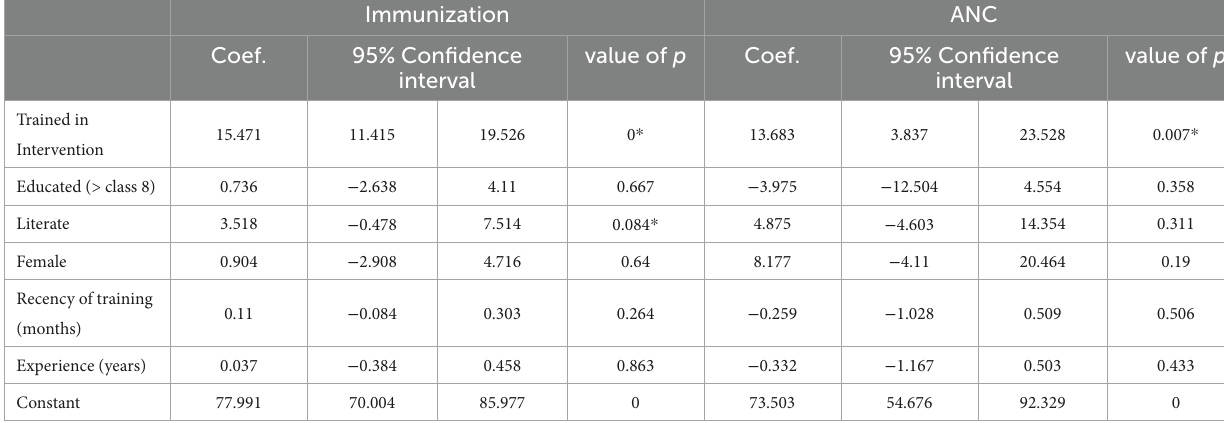
TABLE 5 Linear regressions,